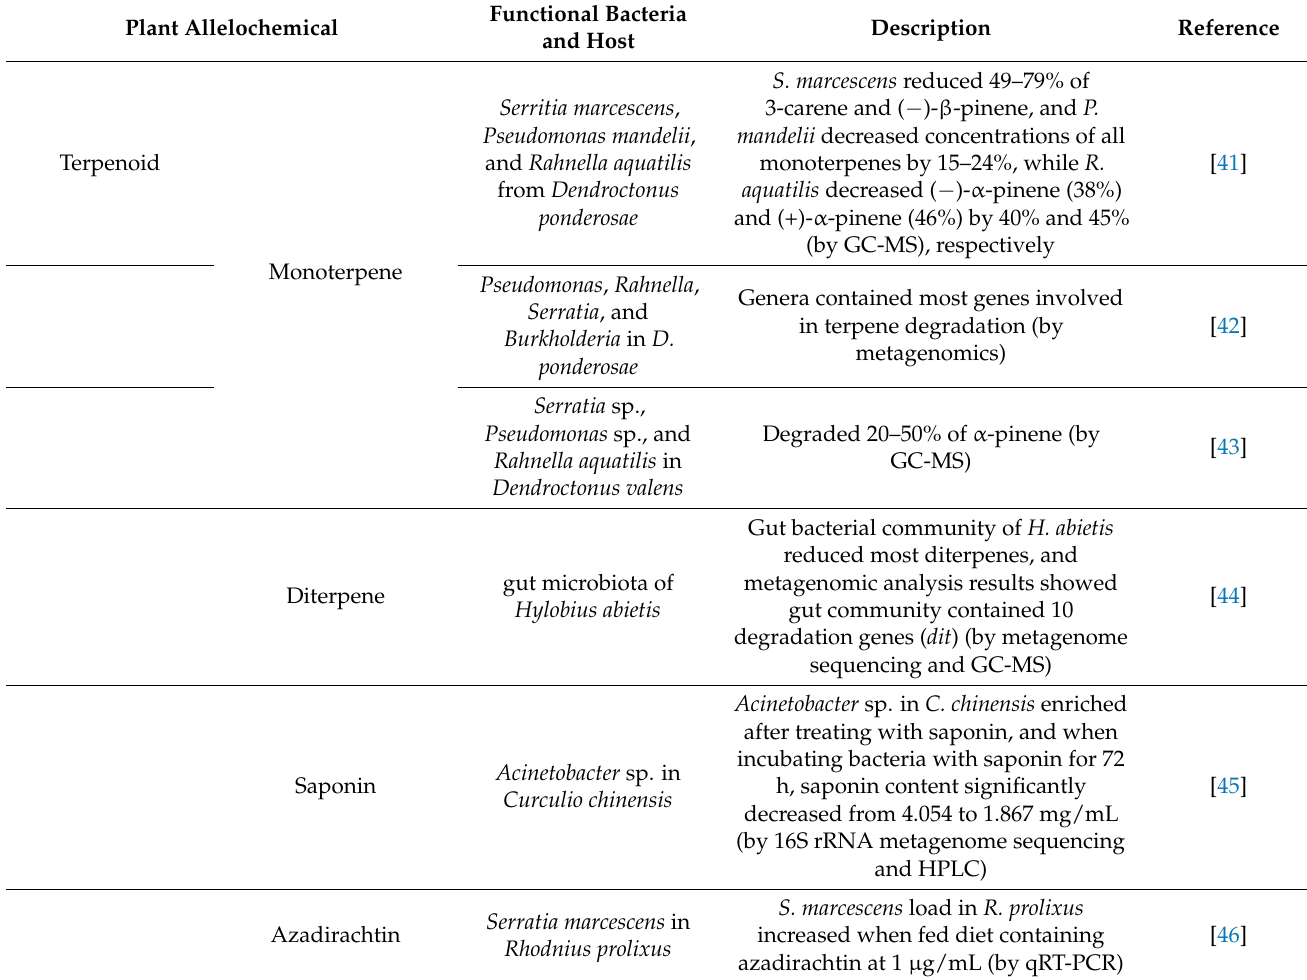
Table 1. Symbiont-mediated detoxification of